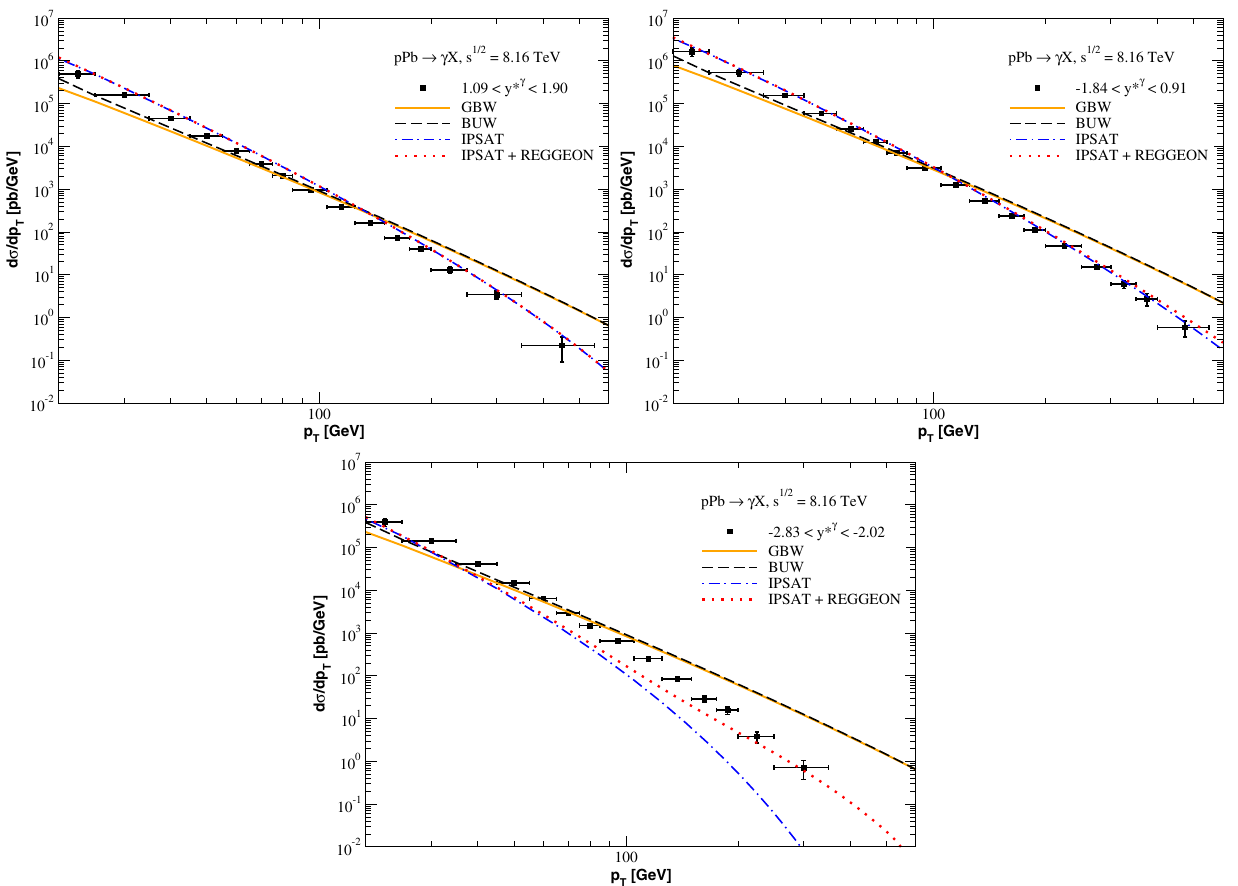
and compared to the experimental data from ATLAS experiment [60]. Reggeon contribution is also investigated (see